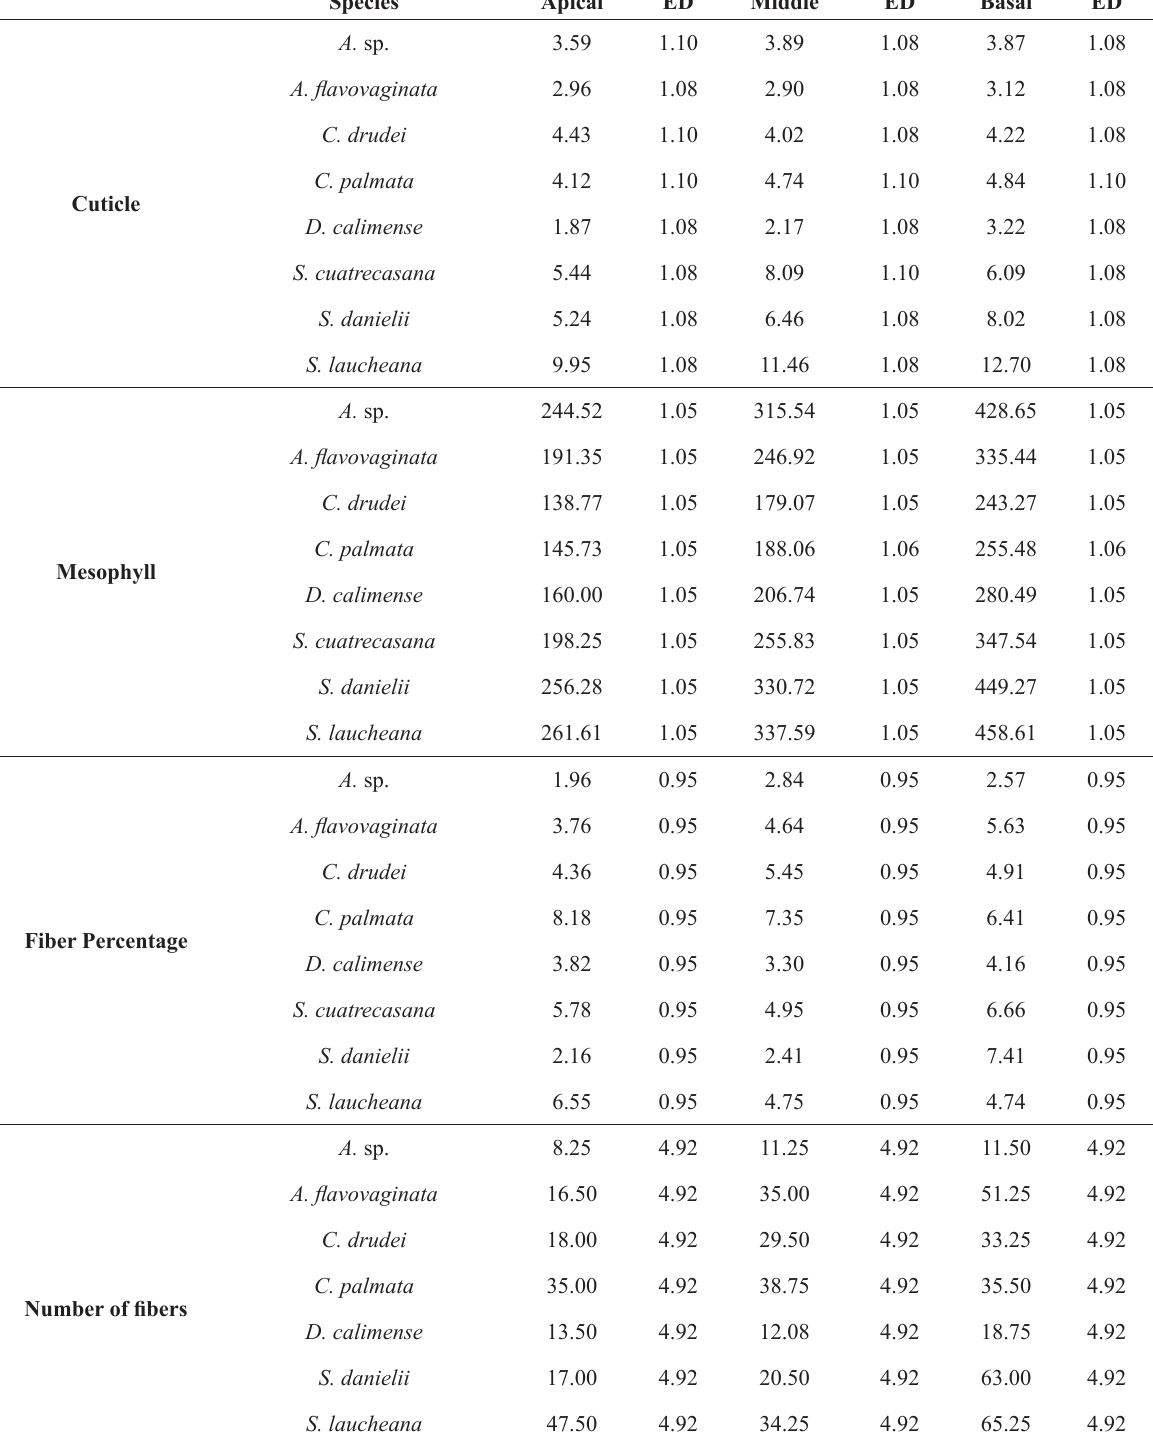
Mean values (micrometers) of measurements of thickness of the cuticle, mesophyll thickness, percentage and number of fibers in the mesophyll with their respective standard deviations. Species Apical ED Middle ED Basal